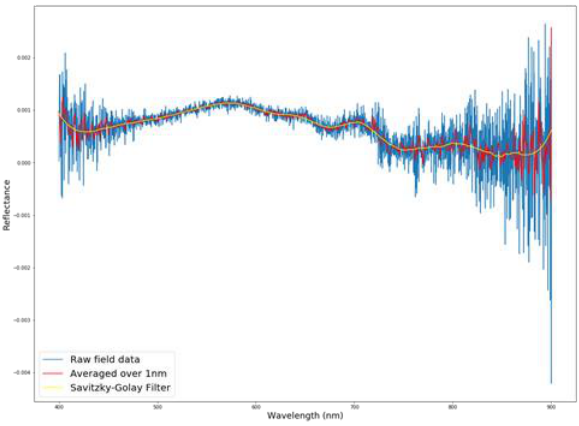
Figure 6. Field sample spectral data smoothing using Savitzky- Golay filter